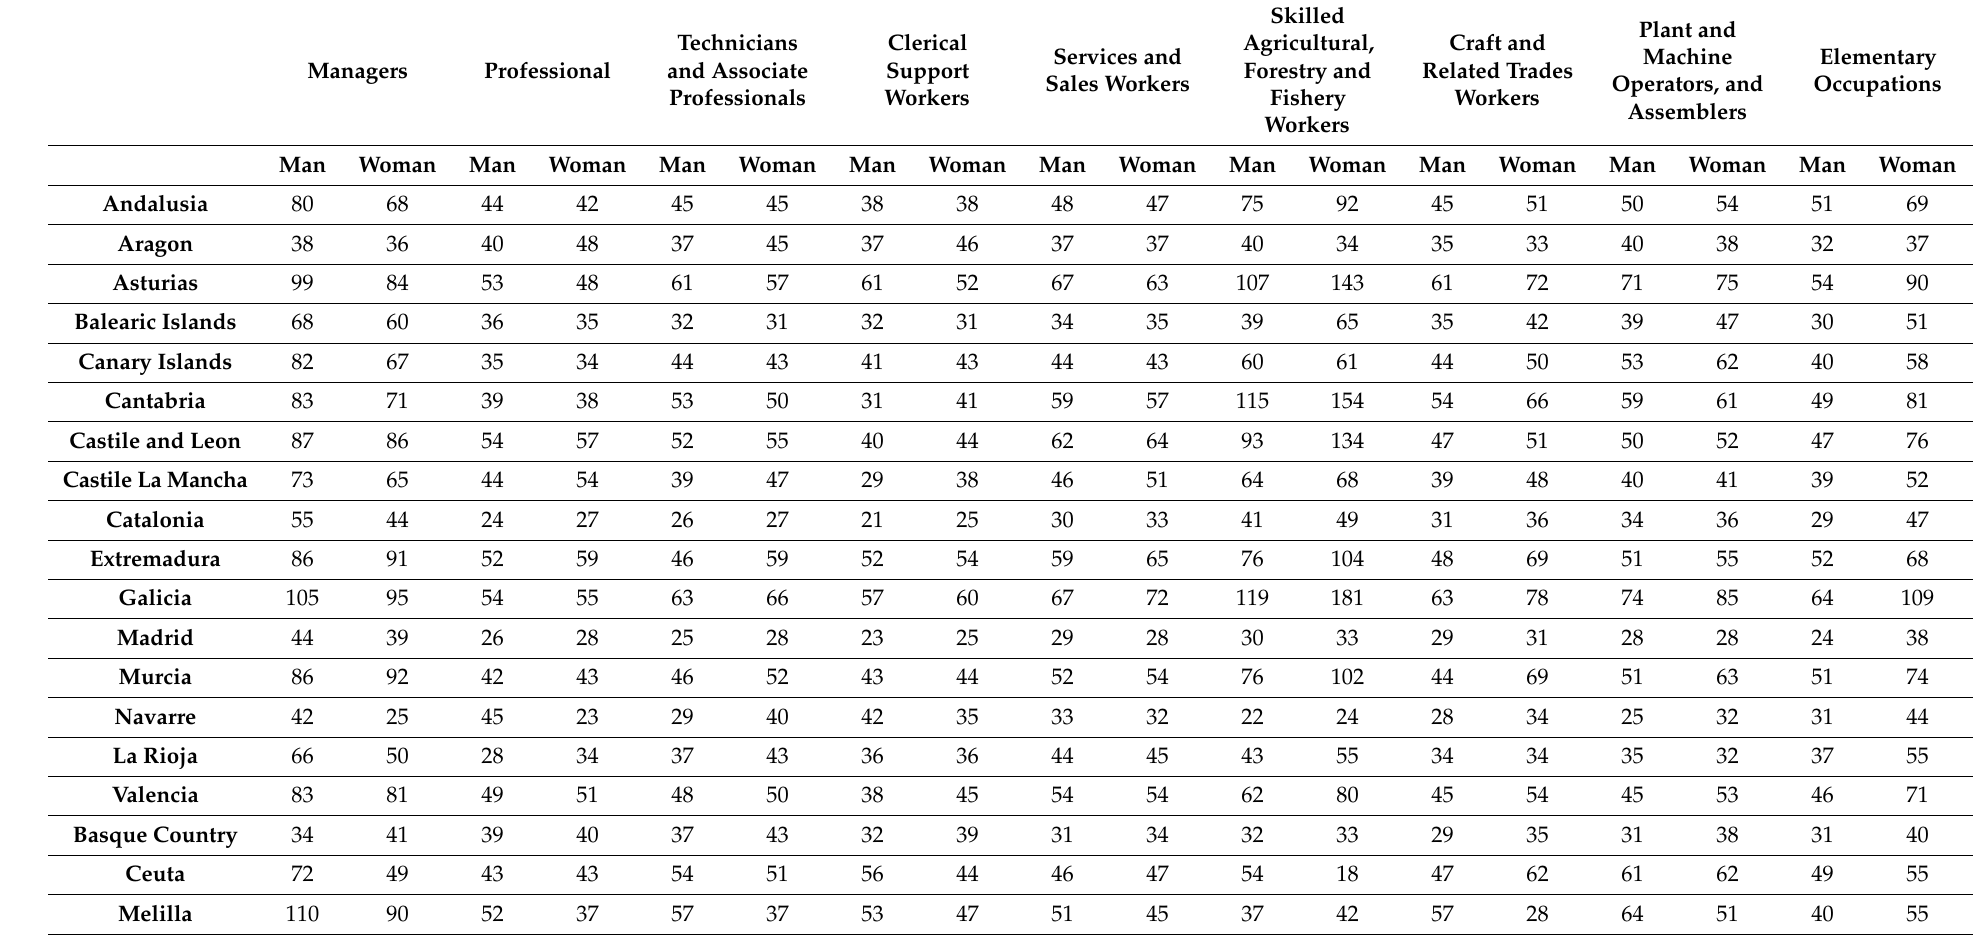
Table 2. Average duration of sickness absence by gender and